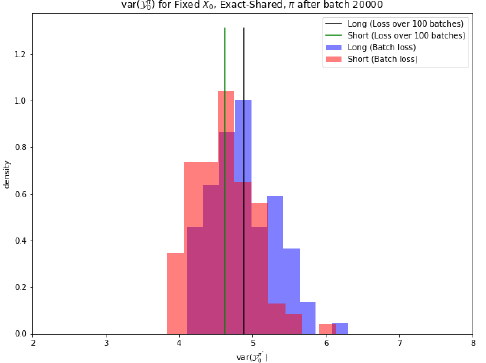
Figure 7. Distribution of batch means of the rollback Y π the optimization. Straddle. Backward method with exact backward step. Single DNN for π . Batch size 512.